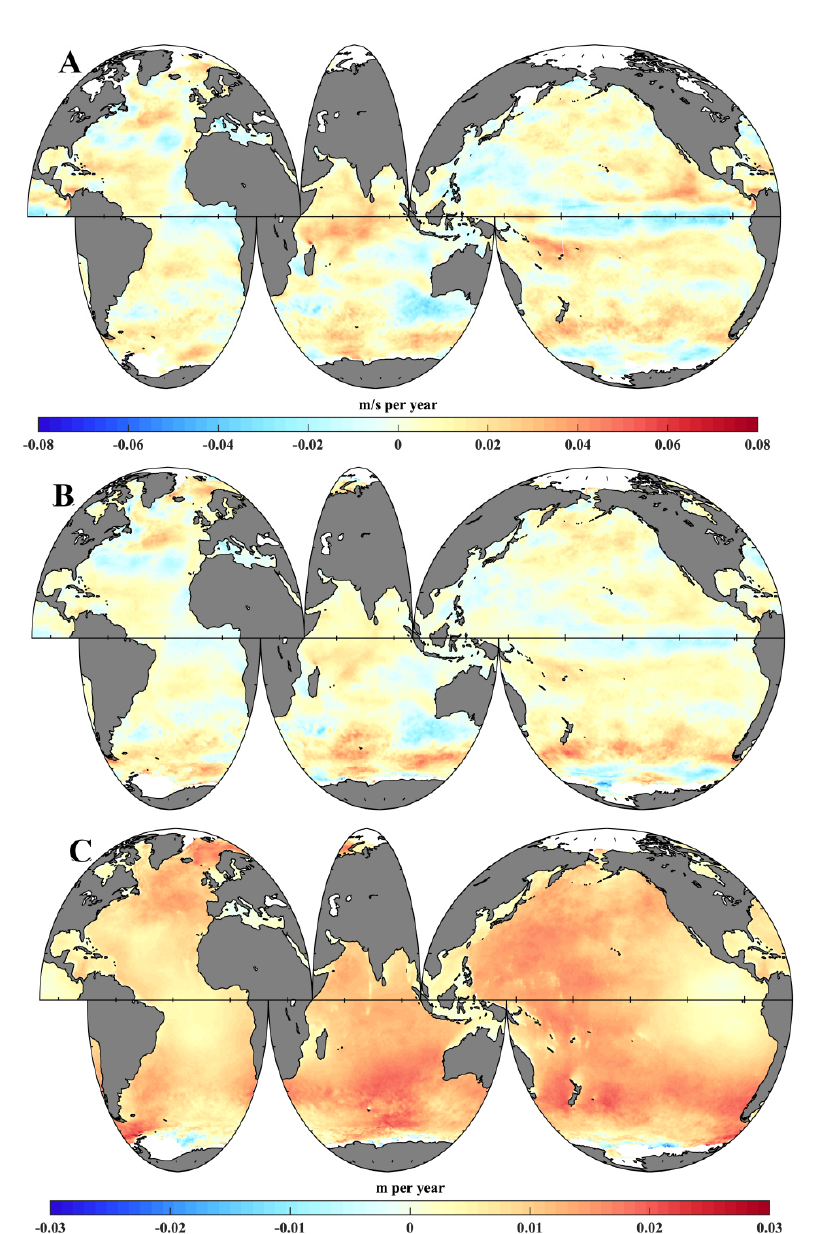
Figure A1. Spatial distributions of global annual SWH trends for 1999–2013 from (A) altimeter, (B) ERA-Interim and (C) ERA5.